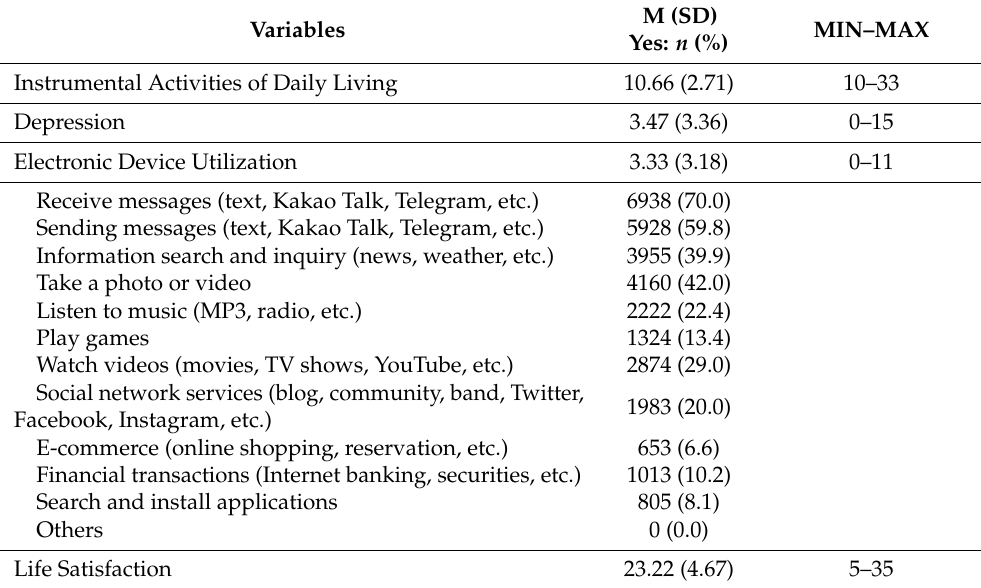
Table 2. Descriptive statistics of study variables ( n =